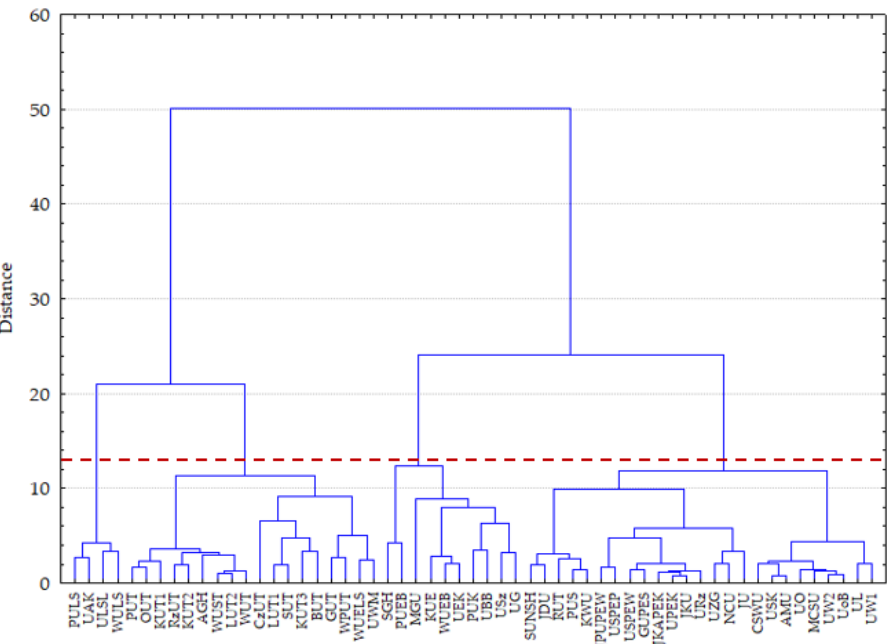
Figure 1. The dendrogram of hierarchical clustering using Ward’s method for selected HEIs from Poland. Source: own study.